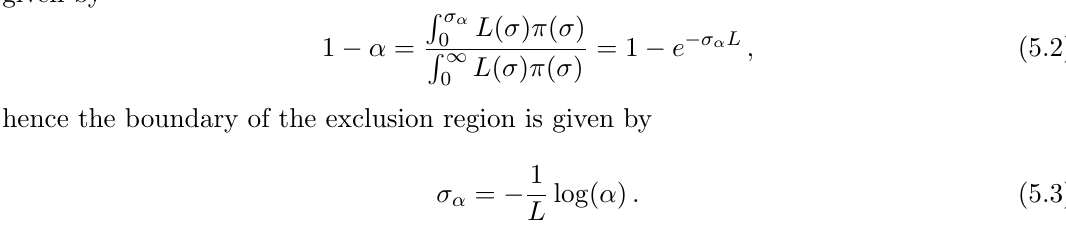
Figure 5 . Distributions of the ratio of the diphoton mass reconstructed with the forward detectors p m pp = (cid:24) 1 (cid:24) 2 s to the reconstructed diphoton mass m (cid:13)(cid:13) (left) and the di(cid:11)erence of the diphoton rapidity y (cid:13)(cid:13) and the rapidity reconstructed with the forward detectors y pp = 1 (right). Diphoton candidates in these plots have passed the elastic selection and the mass lower- bound of 600 GeV. A strong correlation between the forward-backward and central information can be seen for the signal (light blue), while for the background (red line) we see these variables are uncorrelated. We select diphoton candidates lying inside the dashed vertical lines. The width of the signal in these plots is caused mainly by the (cid:24) 1 ; 2 resolution. The integrated luminosity is 300 fb (cid:0) 1 and the average number of pileup interactions is (cid:22) = 50. The intact protons lie within